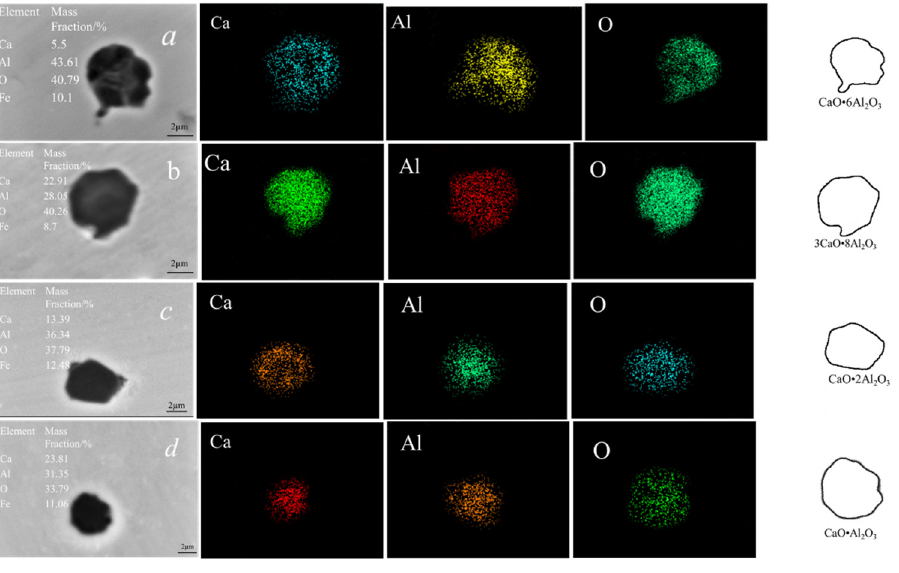
Figure 5. Elemental mappings of different types of inclusions detected after calcium additions in steel B: ( a ) 60 s; ( b ) 180 s; ( c ) 600 s; ( d ) 720 s. steel B: ( a ) 60 s; ( b ) 180 s; ( c ) 600 s; ( d ) 720